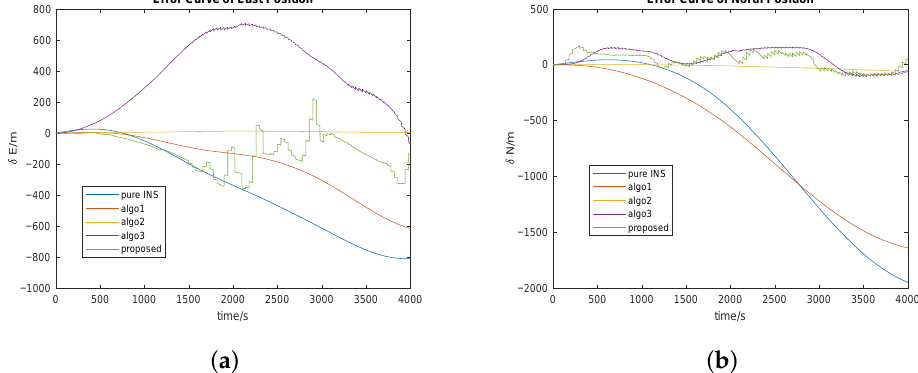
Figure 11. ( a ) Error curve of INS only, algo1, algo2, algo3, and the proposed method in east position; ( b ) error curve of algo1, algo2, algo3, and the proposed method in east